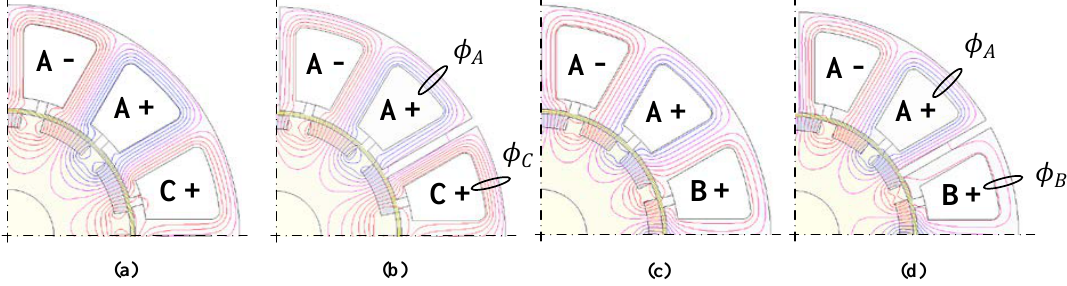
Figure 7. Flux distribution of the four machines. ( a ) 12s / 10p integral machine; ( b ) 12s / 10p E-core modular machine; ( c ) 12s / 14p integral machine; ( d ) 12s / 14p E-core modular machine.